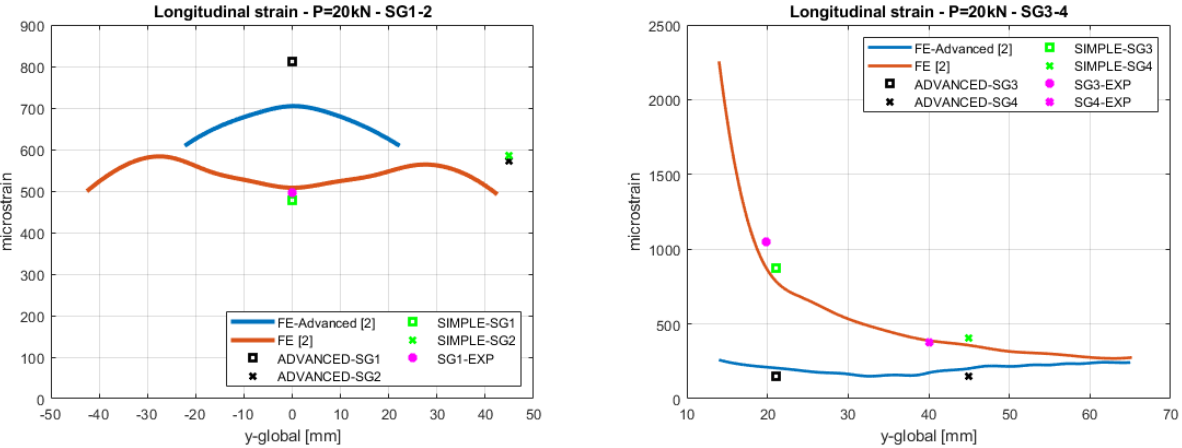
Figure 12. Strain comparison for SG 1–2 and 3–4 between static FE [2] and present numerical simulation. Experimental strain values are from Frulla et al. [1].